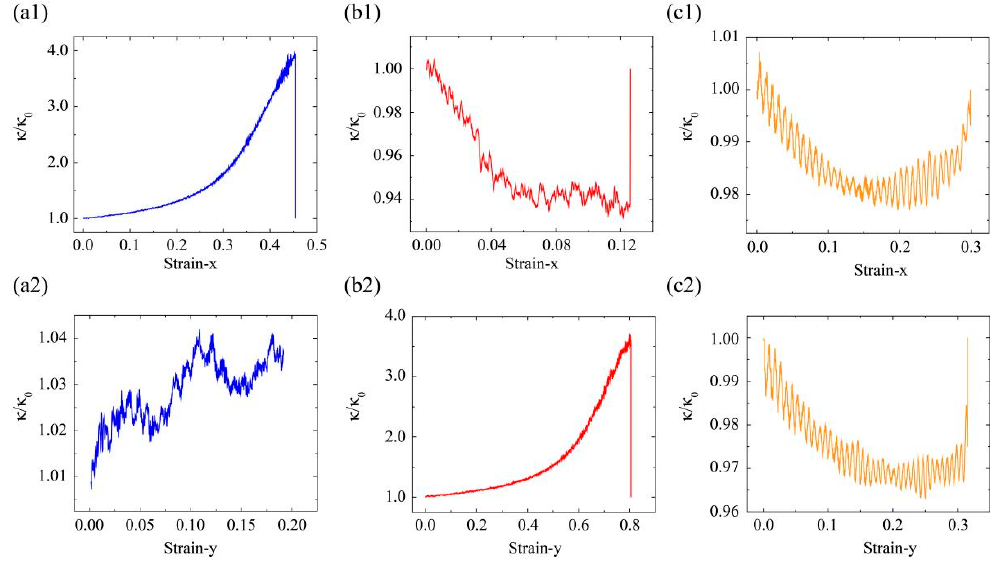
Figure 10. The variation of κ / κ 0 , 1 / (1– v × ε l ), in these GKS models (QSS, RHH, and SKG) under various uniaxial tensile strains along x- ( a1 – a3 ) and y-directions ( b1 – b3 ), respectively.